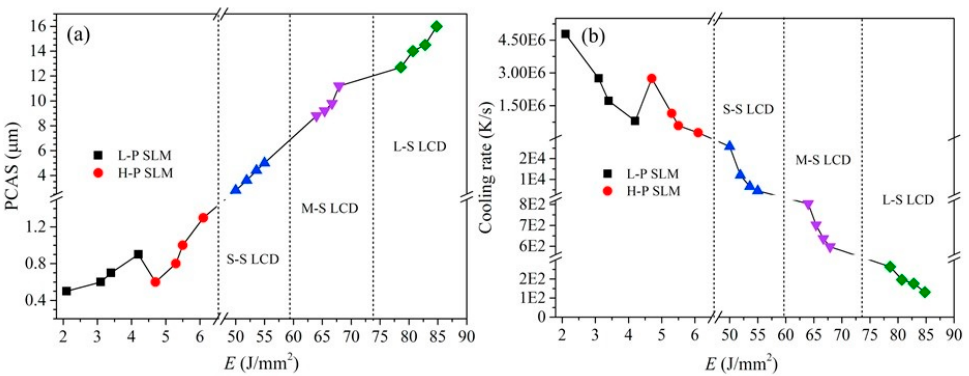
Figure 8. The effect of energy density E on the ( a ) PCAS and the ( b ) cooling rate of the as-forming AISI 316 L stainless steel samples at different processing parameters by LPBF and DED [49].